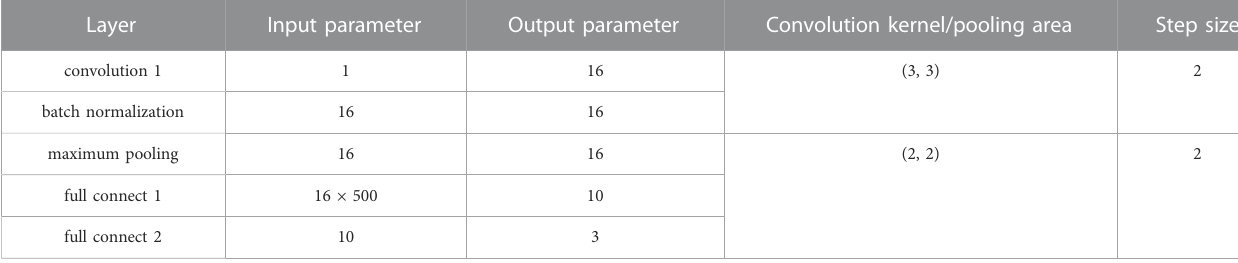
TABLE 6 FFT-CNN-MPL network parameters.